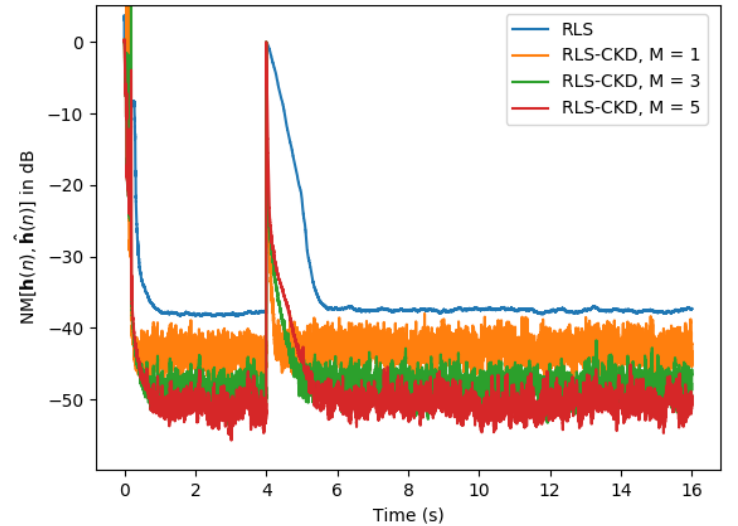
Figure 11. Normalized misalignment of the classical RLS ( L = 2048) and RLS-CKD ( L 1 = 64, L 2 = 8, L 3 = 4) algorithms. The input signal is white Gaussian noise and the impulse response changes after 4